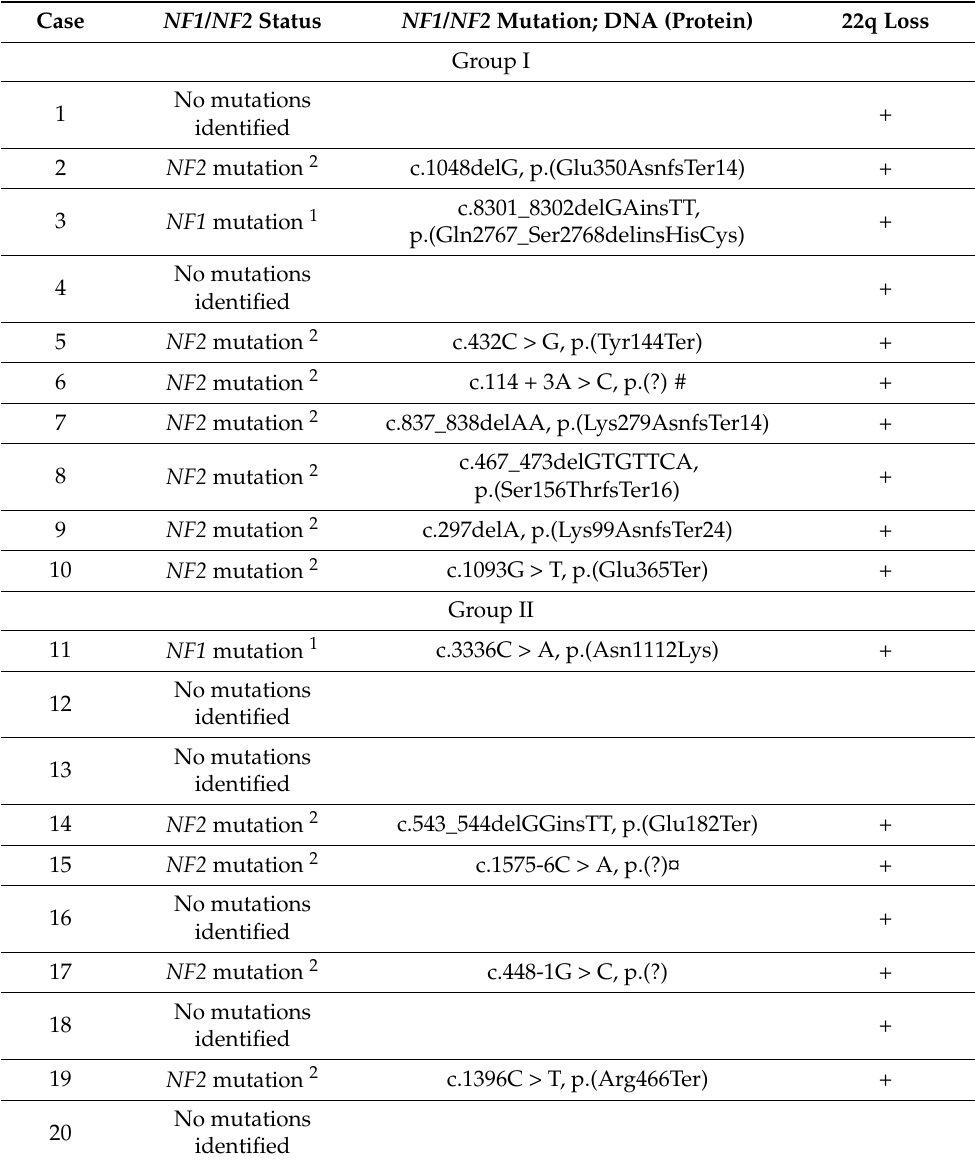
Table 2. NF1/2 gene mutation